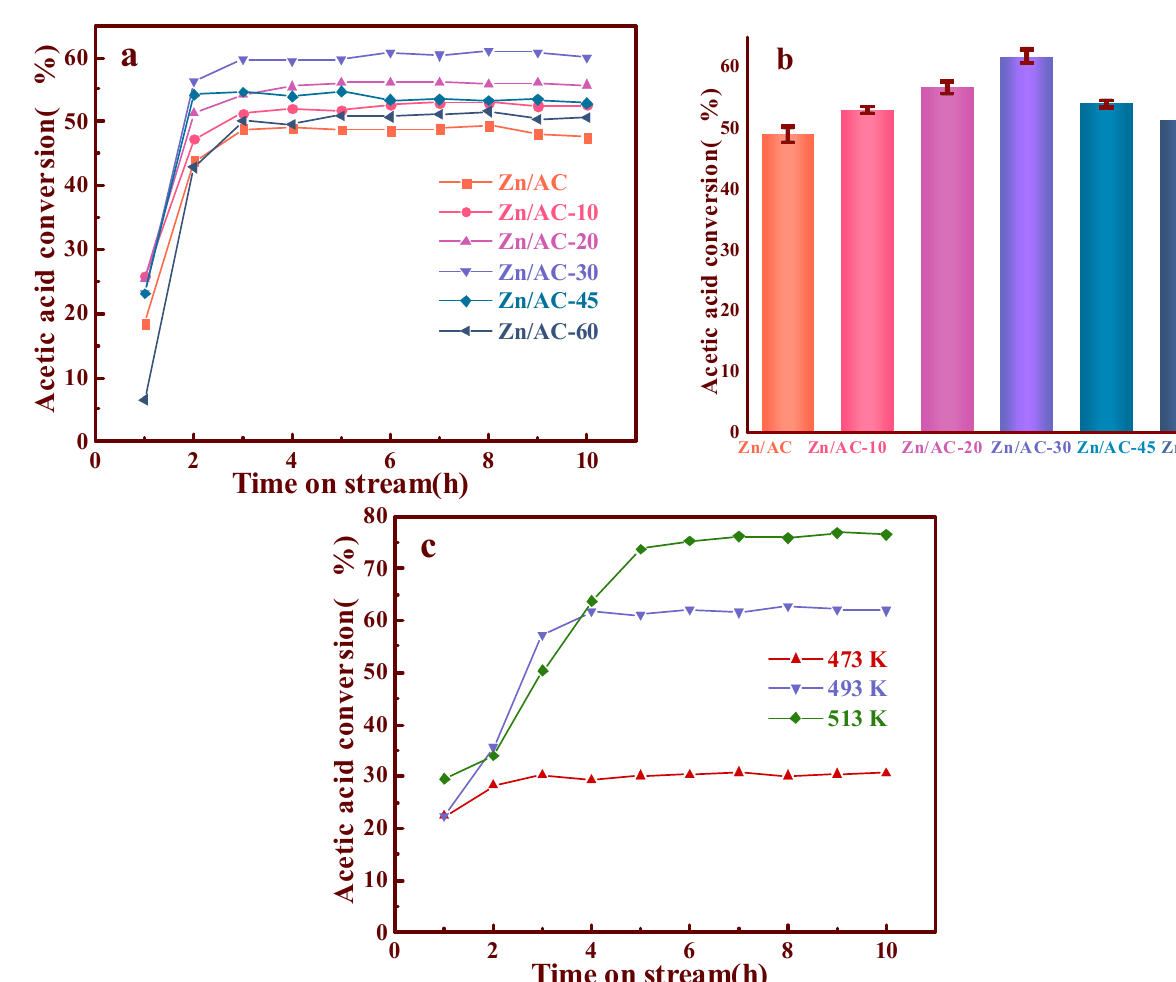
Figure 4. Conversion of CH 3 COOH catalyzed by Zn/AC and Zn/AC-x ( a ); error bars analysis of Zn/AC and Zn/AC-x catalysts ( b ); the effect of reaction temperature ( c ).